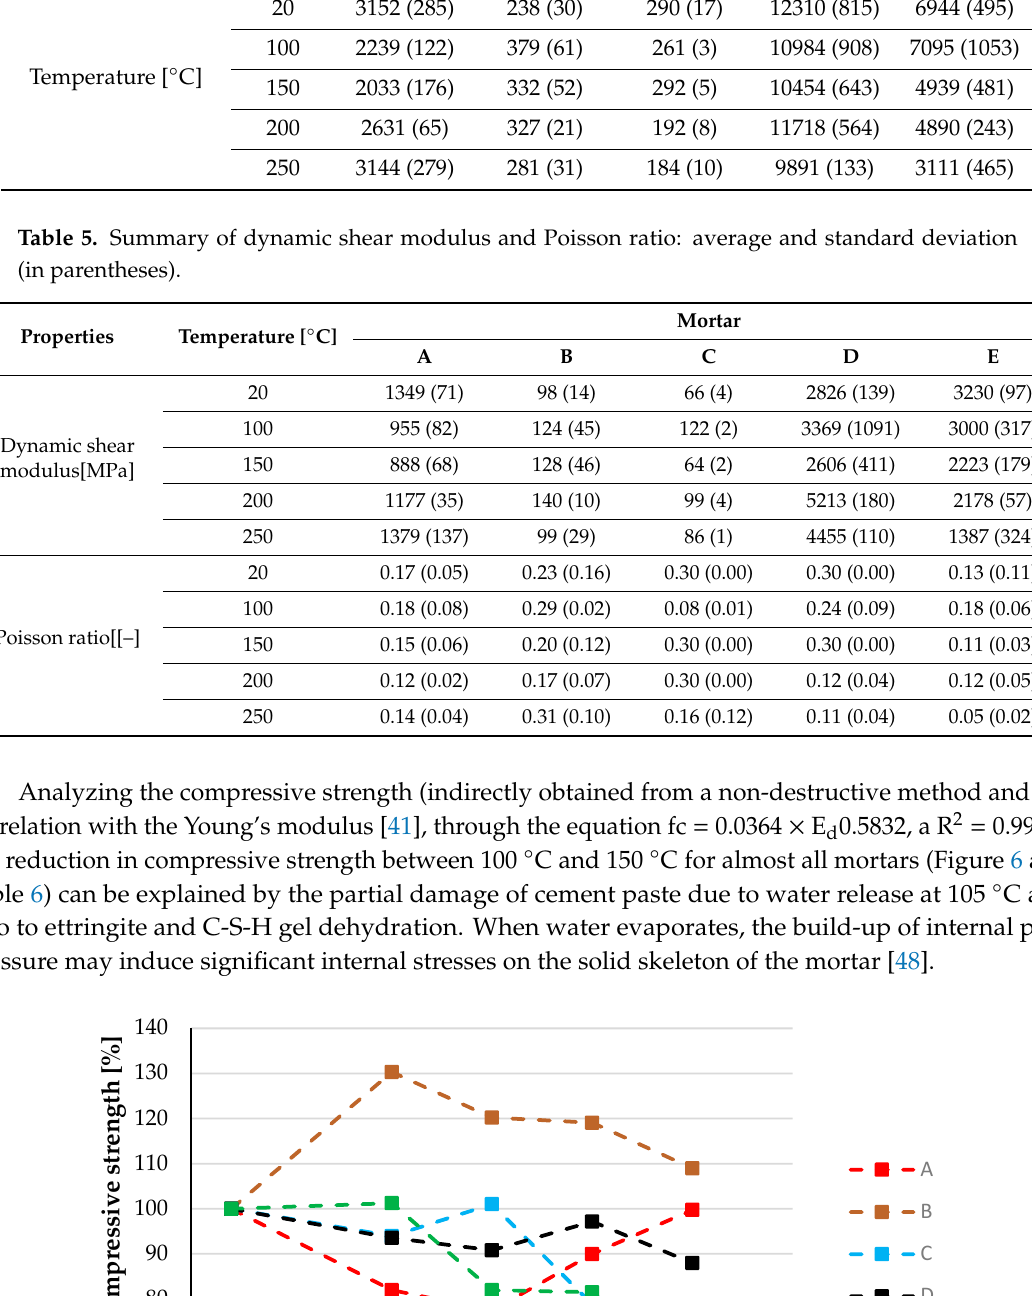
Table 4. Young’s modulus average vs. exposure temperature.